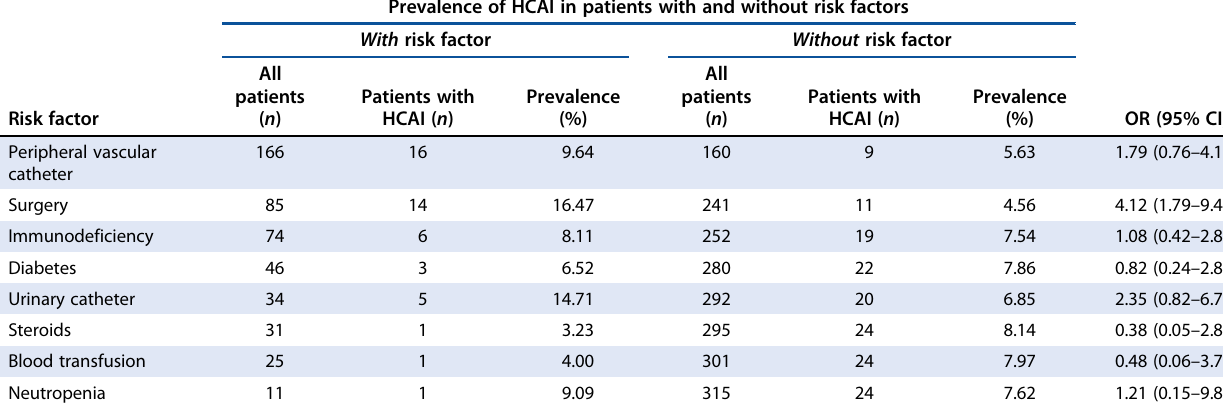
Table 3: Risk factors for healthcare-associated infections ( n = 326)